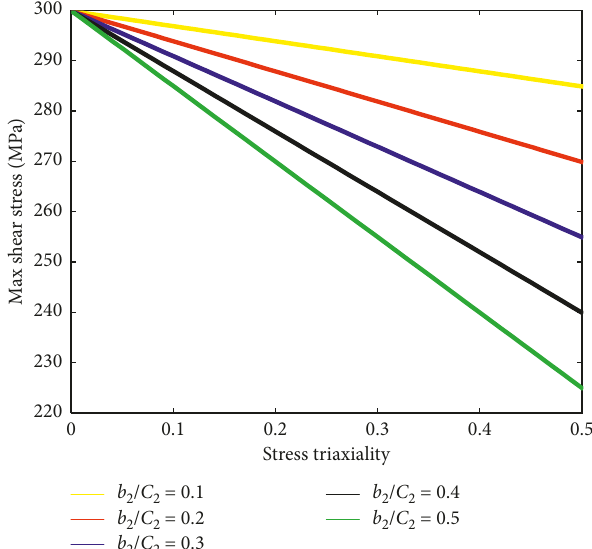
Figure 3: Effect of b 2 in the space of the stress triaxiality and maximal shear